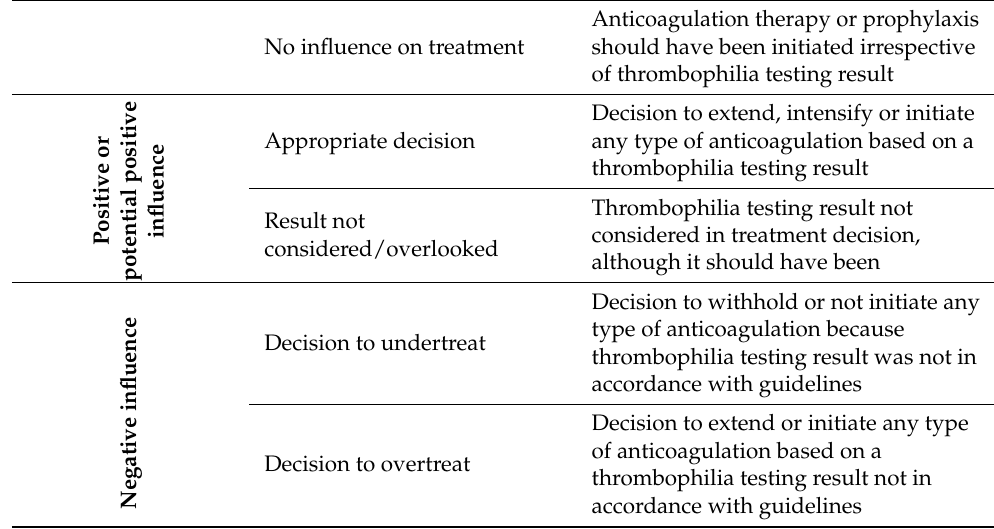
Table 1. Classification of thrombophilia result influence on treatment